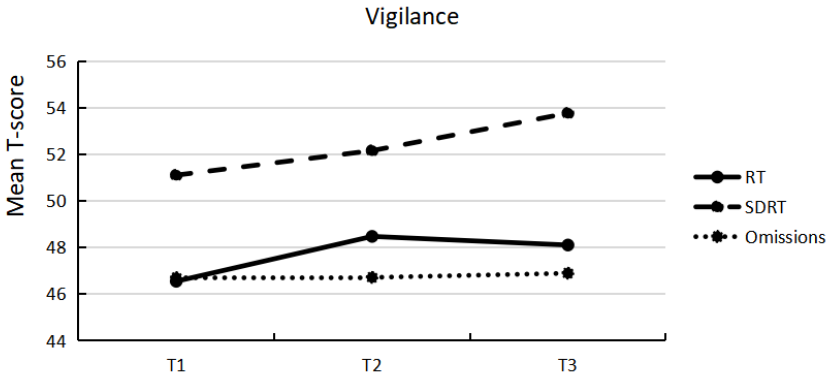
Figure 2. Mean T-score of variables of vigilance at each of the three assessments.